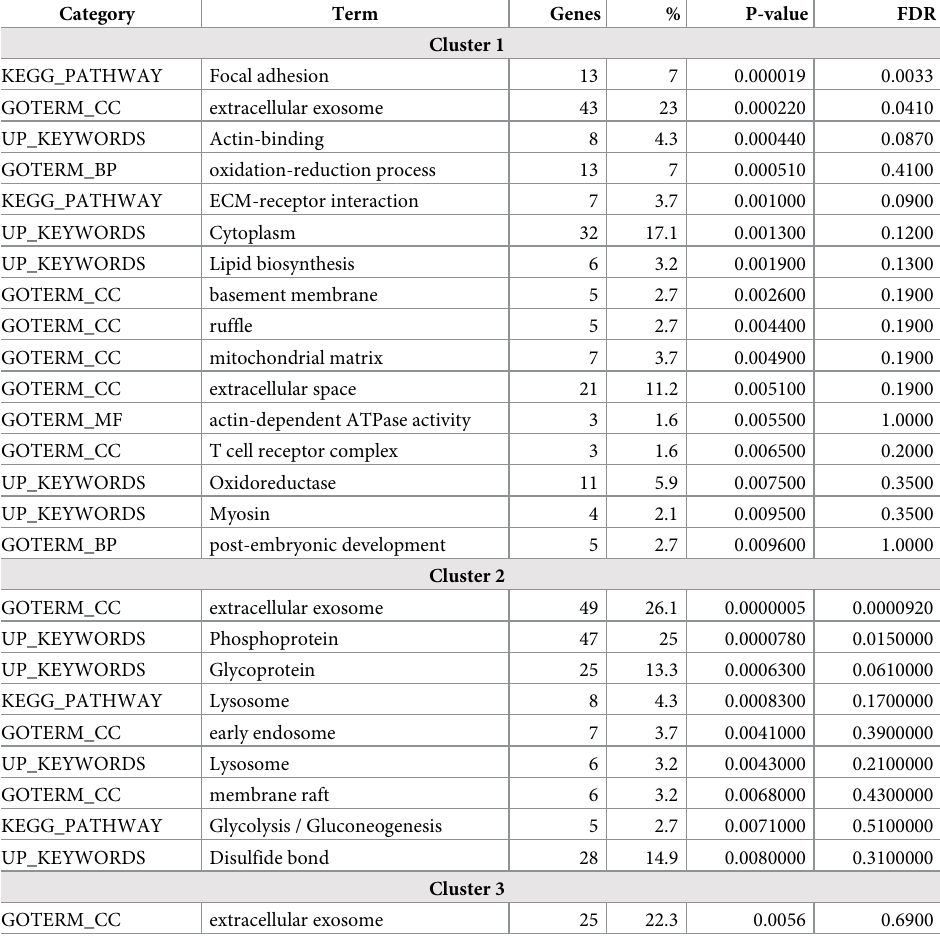
Table 1. Top enriched annotation terms (p < 0.01) in each of the three